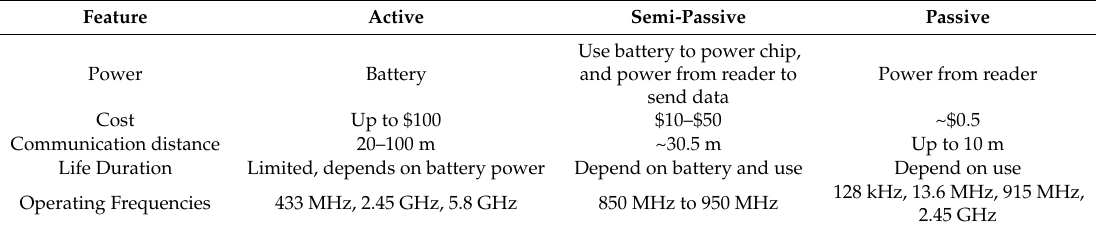
Table 7. Comparison of important features among active, semi-passive, and passive tags.